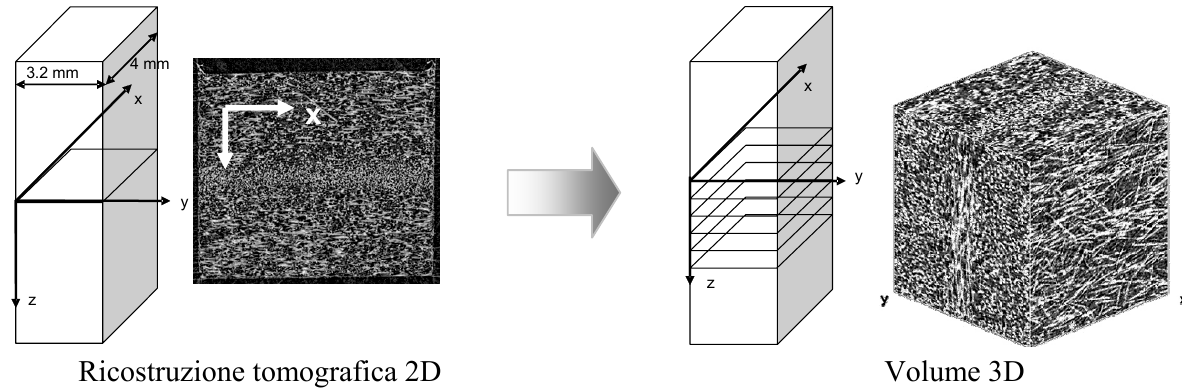
Figura 7: Ricostruzione tridimensionale di un volume cubico di lato 1,8 mm, a partire dalle ricostruzioni tomografiche 2D. Le fibre appaiono di colore chiaro.